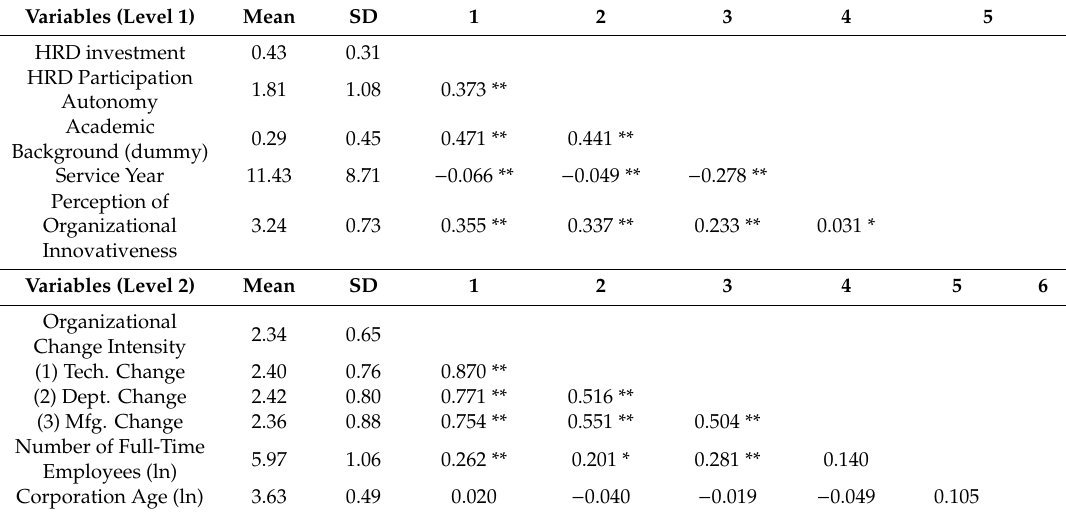
Table 1. Means, standard deviations (SD), and